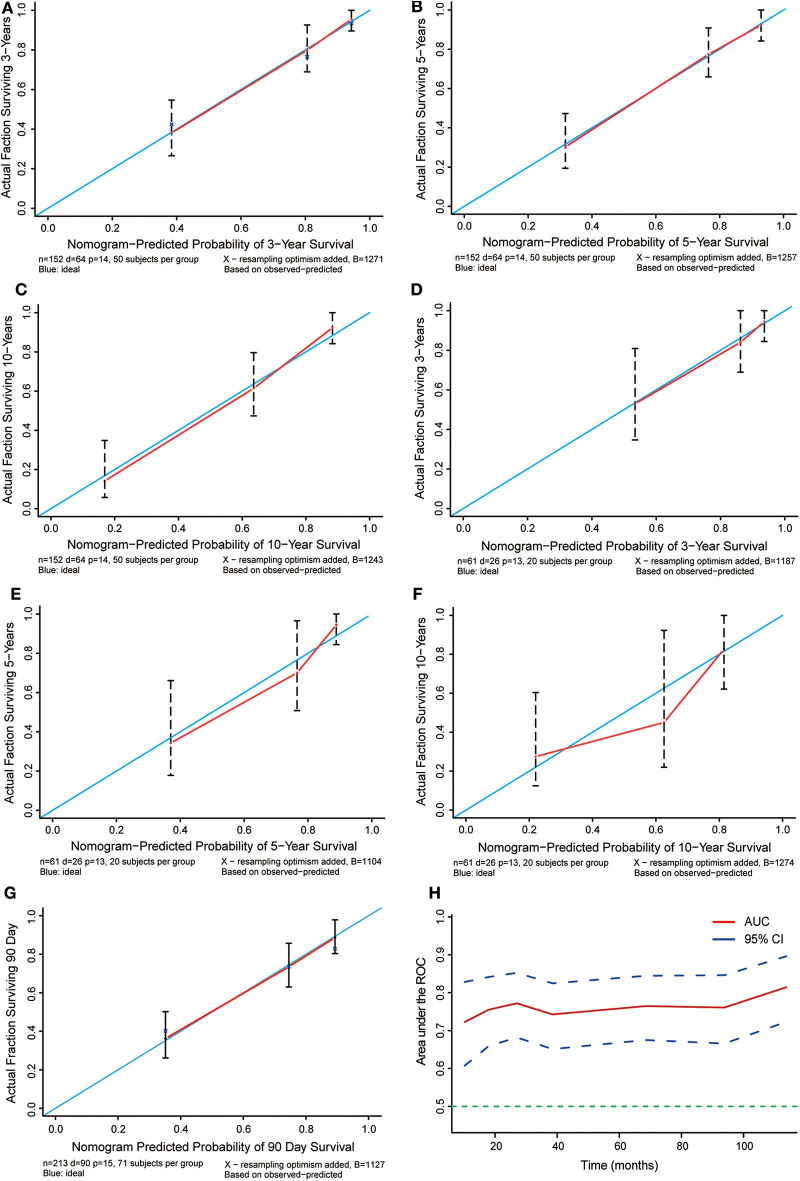
Calibration plots for the prediction of cancer-specific survival at 36-, 60-, and 120-months. (A–C) Calibration curves displaying the probability of 36-, 60-, and 120-month cancer-specific survival between the actual observation and the probability predicted by the nomogram in the primary cohort. (D–F) Calibration curves showing the probability of 36-,60-, and 120-month cancer-specific survival between the actual observation and the probability predicted by the nomogram in the validation cohort. The blue lines with a slope of 1 were ideal for prediction. (G) Cross-validation curves showing the probability of 90 day specific survival between the actual observation and the probability predicted by the nomogram in the validation cohort. The blue lines with a slope of 1 were ideal for prediction. (H) Time-dependent ROC curves showing the sensitivity and specificity of the cancer-specific survival prediction by the nomogram.